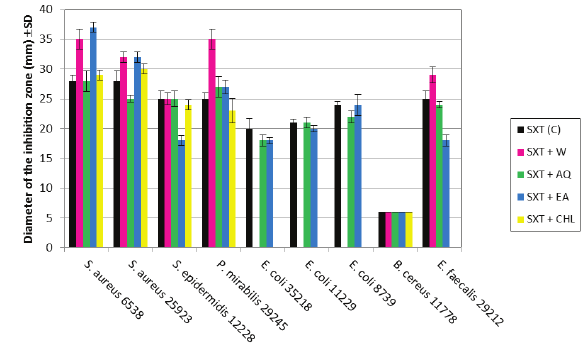
Figure 5: Bacterial strains response to Sulfamethoxazole- Trimethoprim/SXT combinations with the four Arctii folium extracts (SXT+W, SXT+AQ, SXT+EA, and SXT+CHL) comparatively to the antibiotic alone, SXT (C); diameter of the inhibition zone, (mm) ± SD.